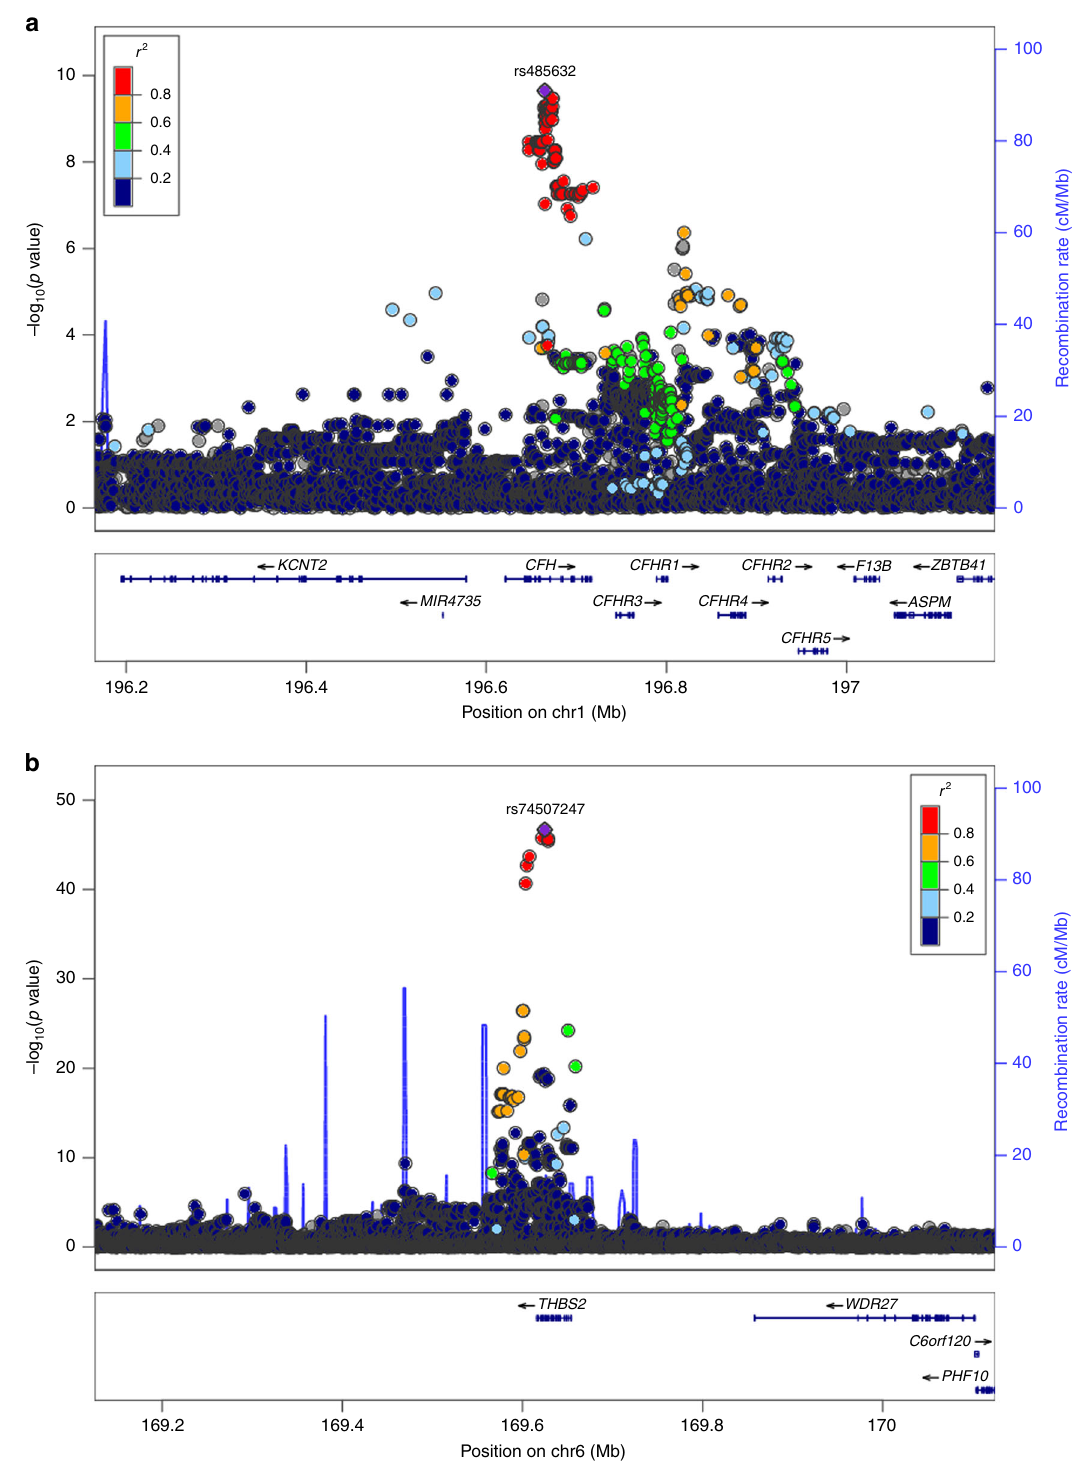
Fig. 5 Association of regulatory genetic variants in cis and trans with plasma proteins. Regional association plots of genetic loci in a cis- associated with thrombospondin-2, and b in trans- associated with C5a at the CFH locus. Plots depict all single nucleotide polymorphisms (SNPs) within ±500 kb of the lead SNP. Circles indicate SNPs with genomic position on the x axis (human genome build 19), p value on the left-hand y axis and recombination rate on the right-hand y axis. Colors indicate pairwise linkage disequilibrium of each SNP with the lead SNP at each